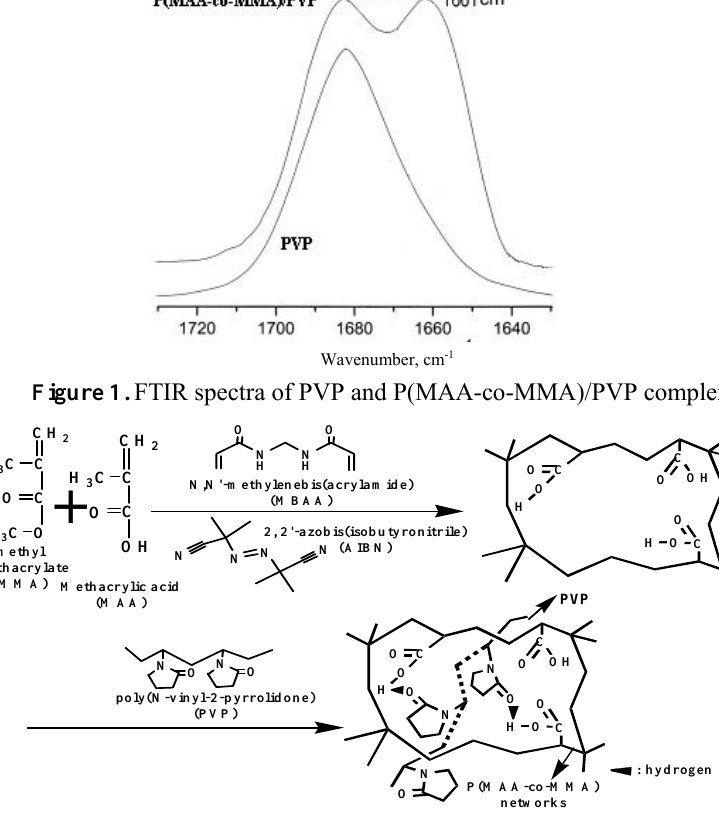
Scheme 1. Synthesis of P(MAA-co-MMA)/PVP